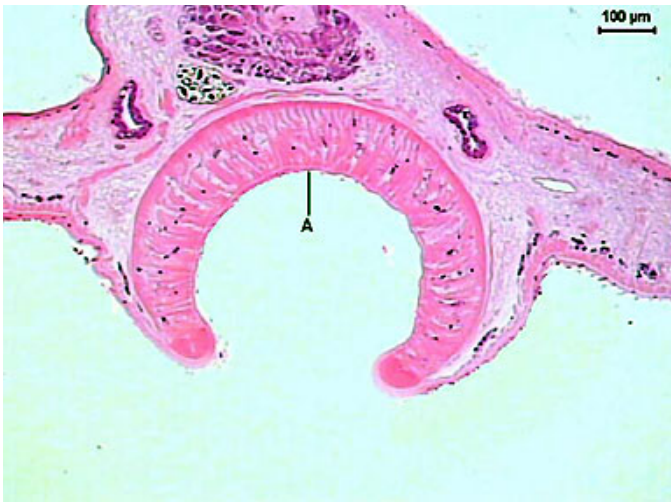
Figure 13. Transversal section of the Sticholecitha serpentis acetabulum (A).